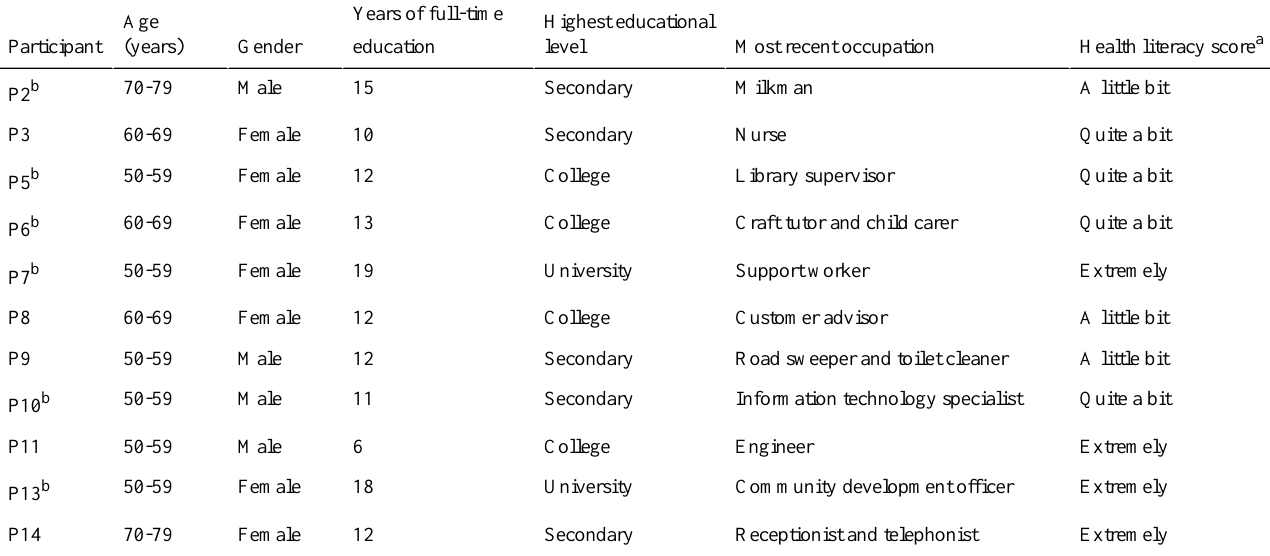
Table 1. Focus group and think-aloud interview participant